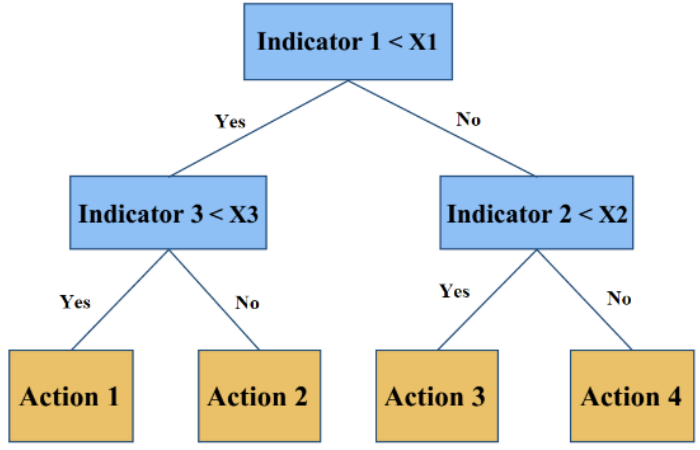
Figure 7. Structure of a policy tree .